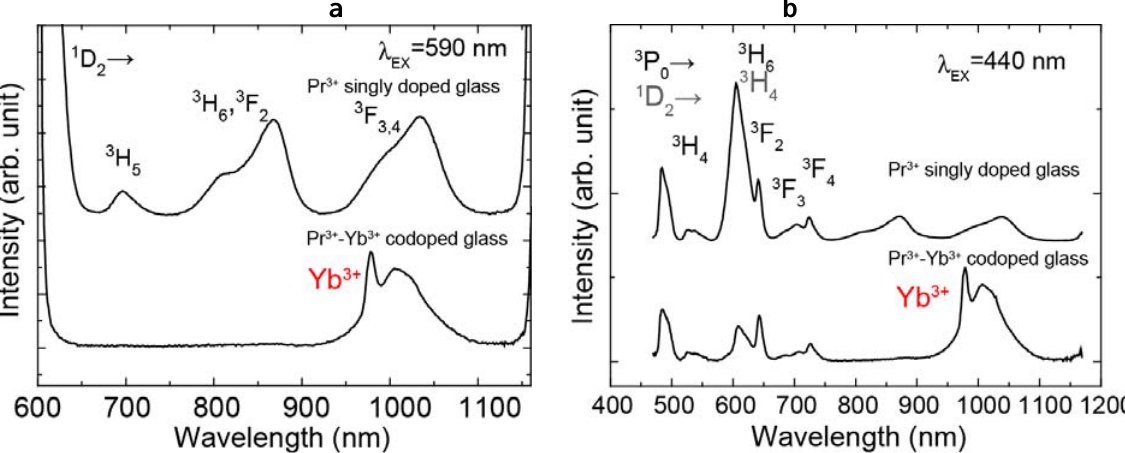
Figure 2. Emission spectra of the Pr 3+ singly doped and Pr 3+ -Yb 3+ codoped samples excited at (a) 590 nm and (b) 440 nm.